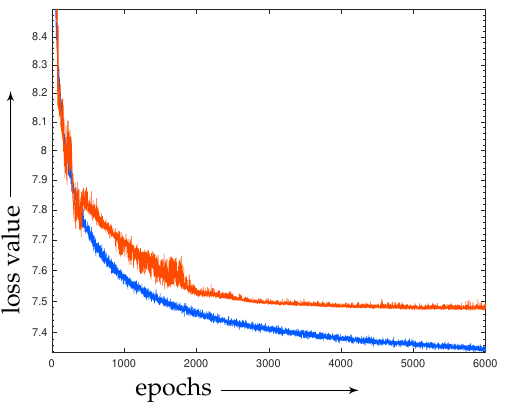
Figure 8. Learning curve. Blue and red points are results for training data and validation data,